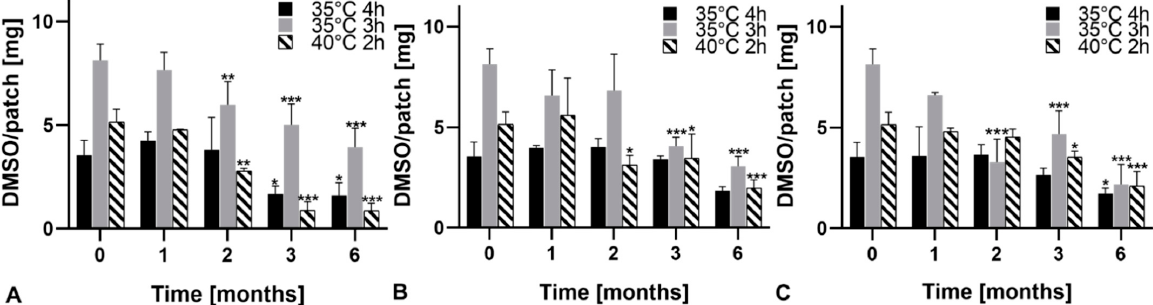
Figure 7. DMSO/patch at different storage conditions over a period of six months. ( A ) 2–8 °C (sealed), ( B ) 25 °C/60% RH (sealed), ( C ) 25 °C/60% RH (unsealed). Residual amounts after one, two, three and six months were compared to the initial amount at t = 0. * Indicates significant differences ( p < 0.05), ** indicates significant differences ( p < 0.01) and *** indicates significant differences ( p < 0.001).